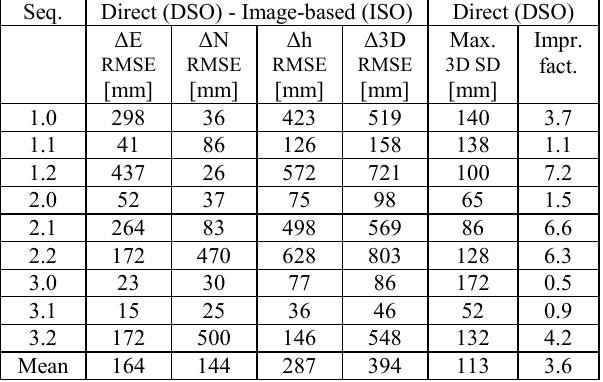
Table 2. RMSE values for deviations of projection centers between direct and image-based georeferencing (RMSE DSO- ISO) as well as maximum 3D position estimates from direct georeferencing (Max. 3D SD DSO)